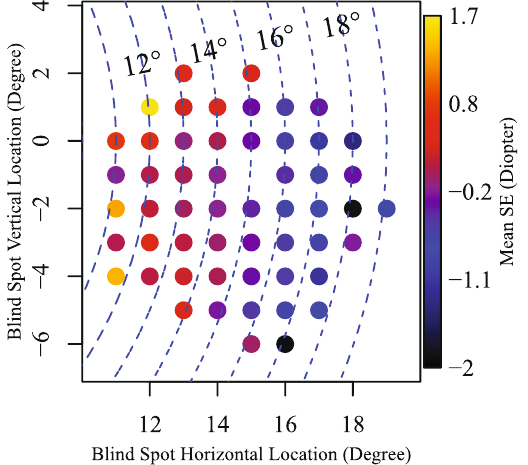
Figure 3. Average values of spherical equivalent over eyes at each NBSL. Blue dashed arc denotes the NBSL distances from